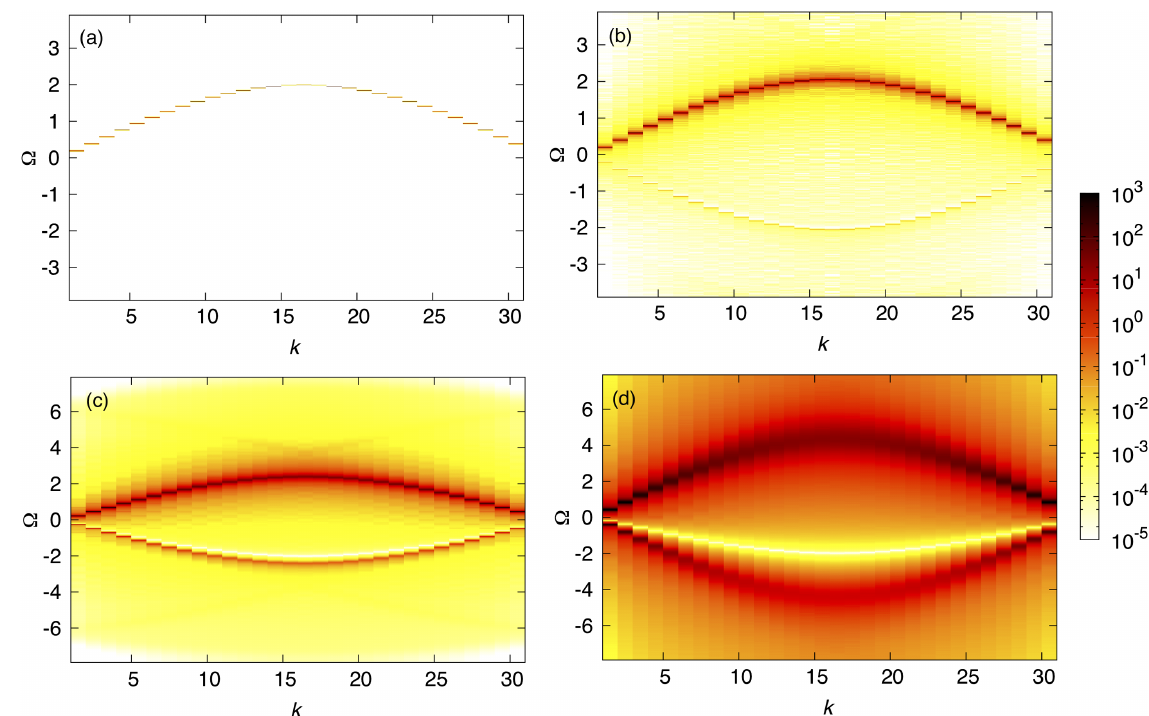
FIG. 1. ð k − Ω Þ spectrum, N ð a Þ ð k; Ω Þ , for different values of ϵ : (a) ϵ ¼ 0 , (b) ϵ ¼ 0 . 0089 (c) ϵ ¼ 0 . 089 (d) ϵ ¼ 1 . 12 . In the linear case, (a), the N ð a Þ ð k; Ω Þ is different from 0 only when the frequency Ω matches the linear dispersion relation. As the nonlinearity is increased, (b) – (d), a frequency shift, a broadening of the frequencies, and a lower branch less intense than the upper one are visible. Waves with negative frequencies are named “ ghost ”